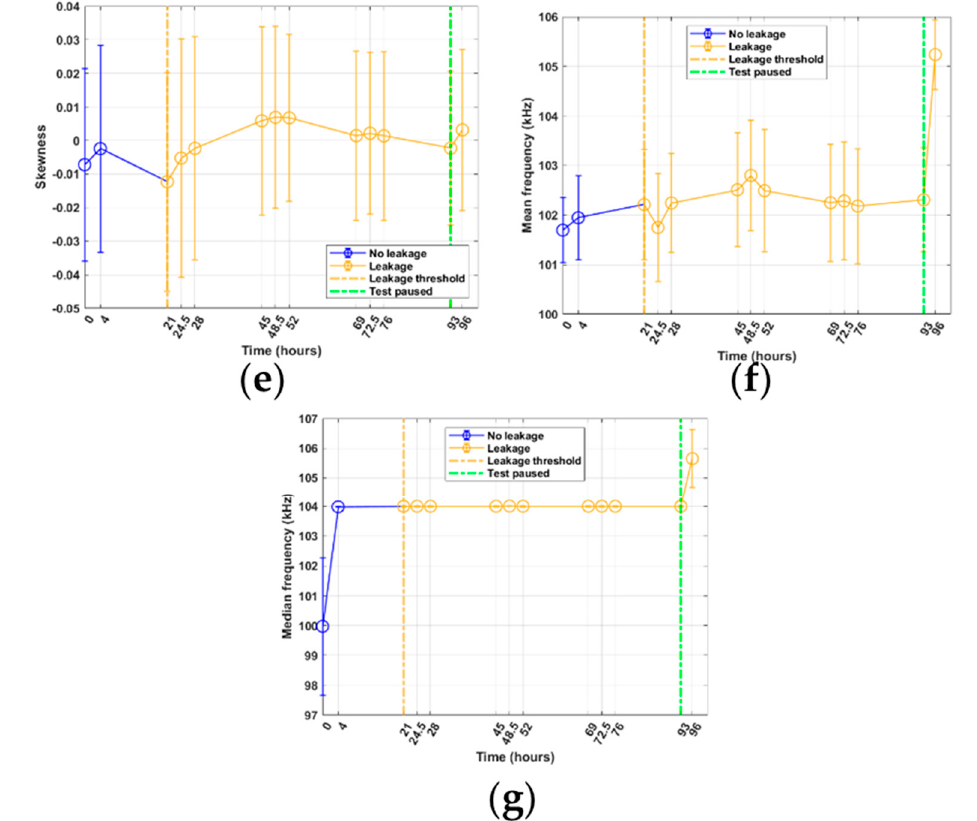
Figure 11. Feature results from RTF test 5: ( a ) RMS; ( b ) peak; ( c ) crest factor; ( d ) kurtosis; ( e ) skewness; ( f ) mean frequency; ( g ) median frequency.